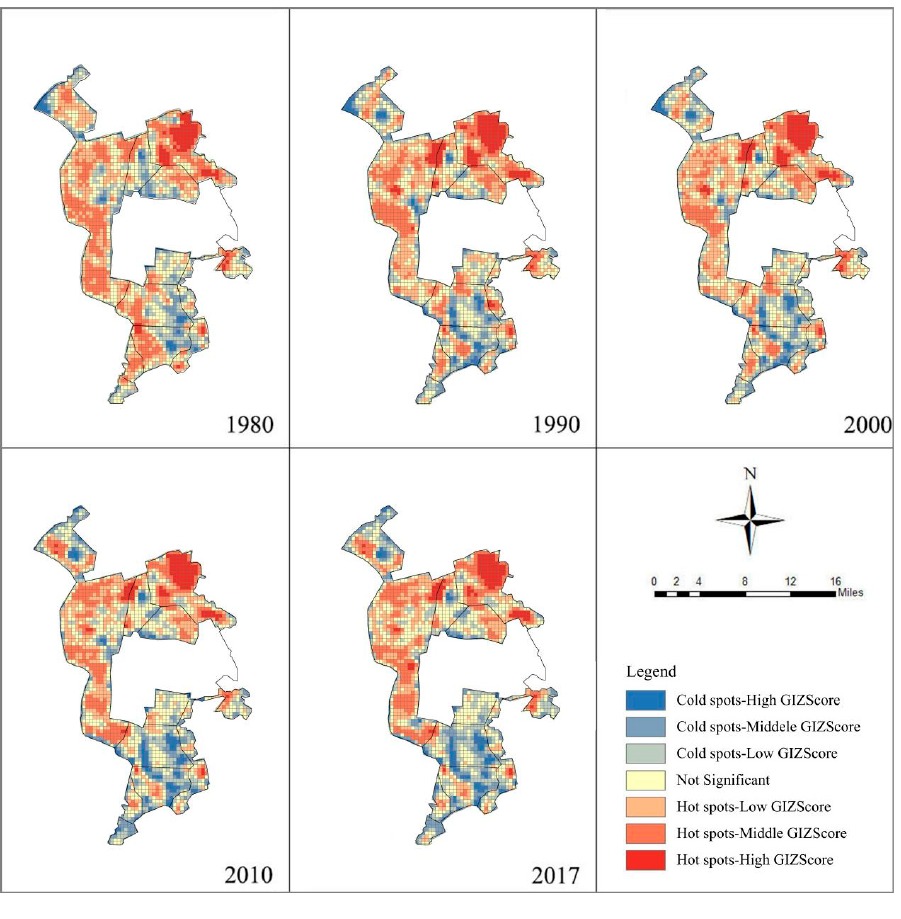
Figure 8. Local spatial autocorrelation analysis in the study area.